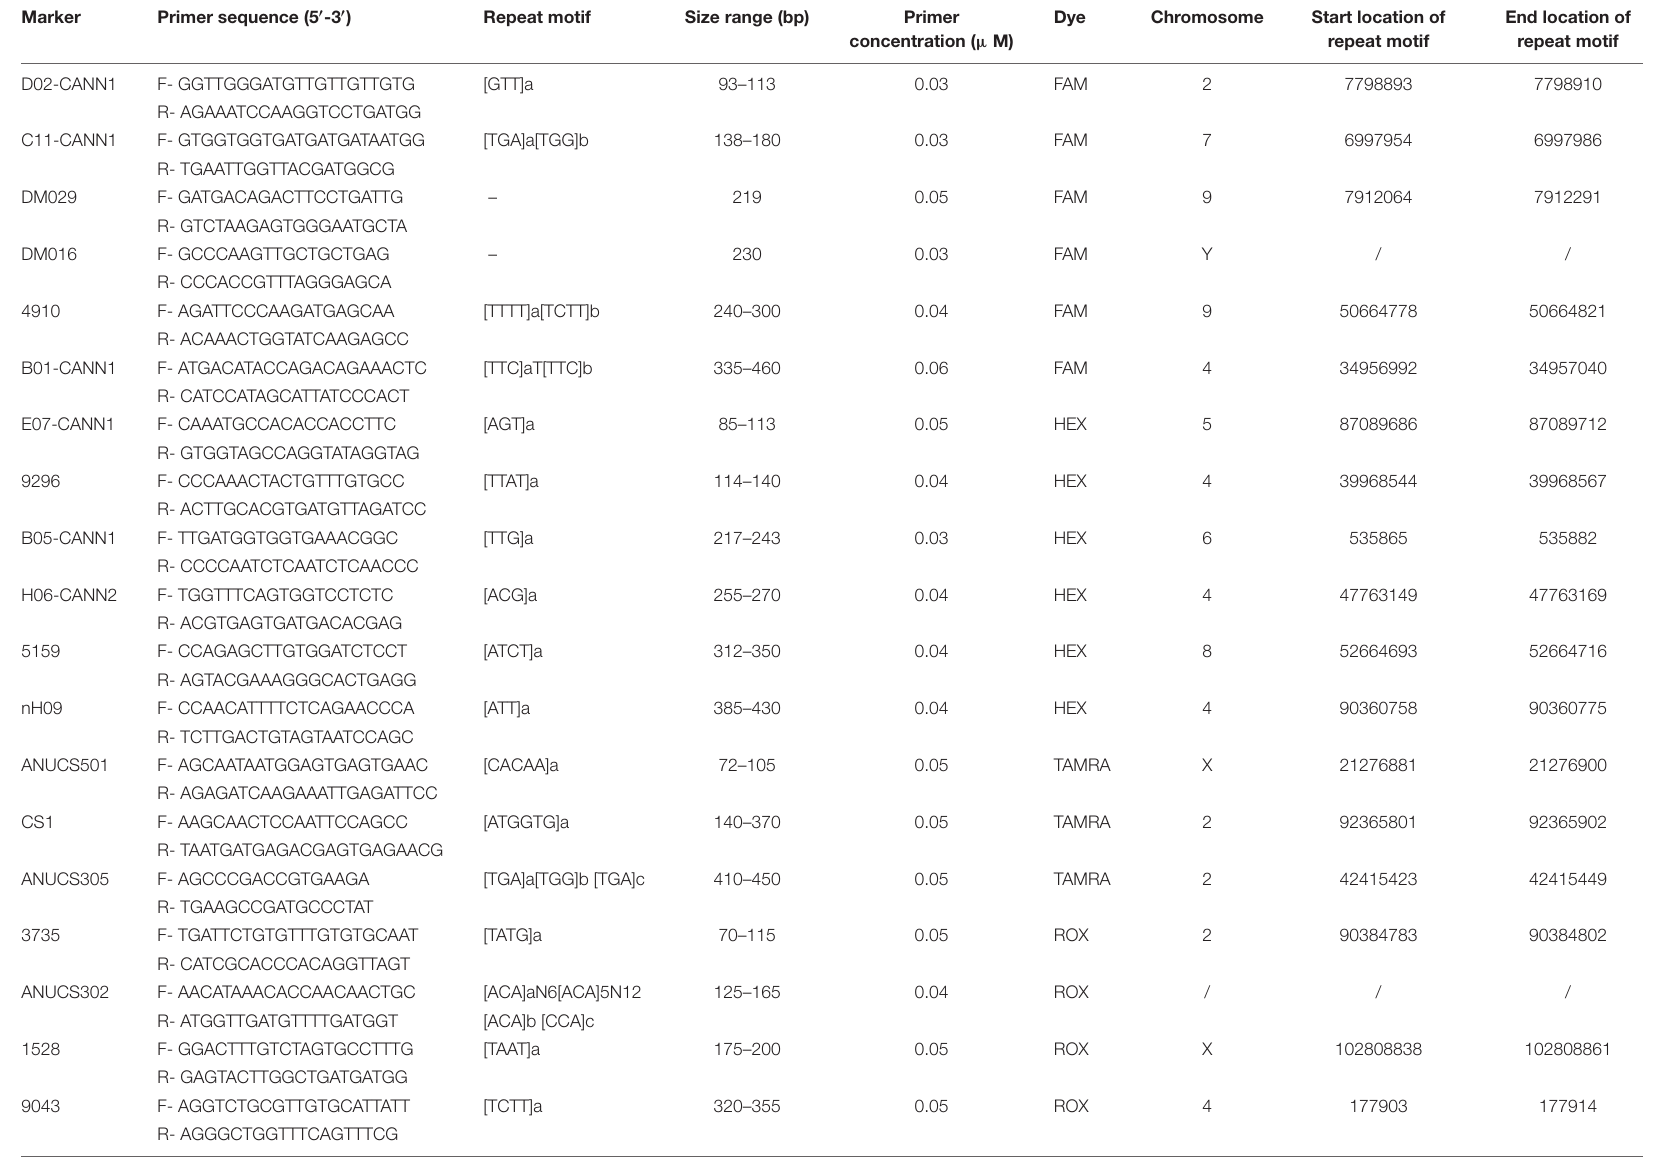
a, b and c represent the repeat number of the repeat